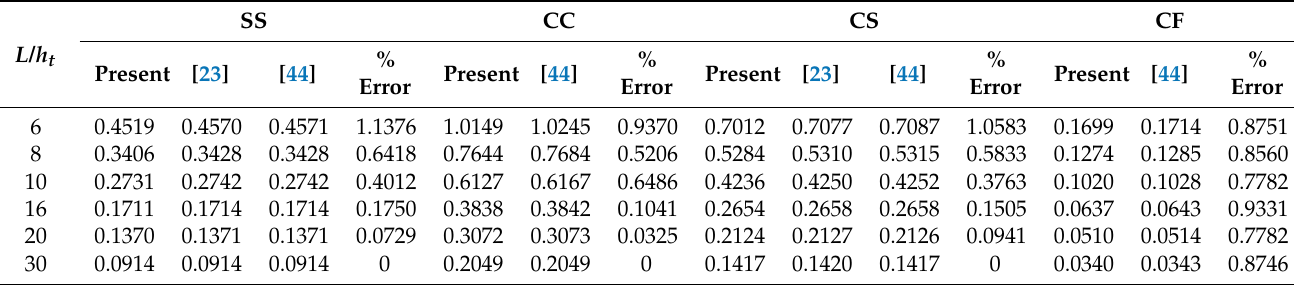
Table 5. Comparison of the estimated nonclassical fundamental natural frequency